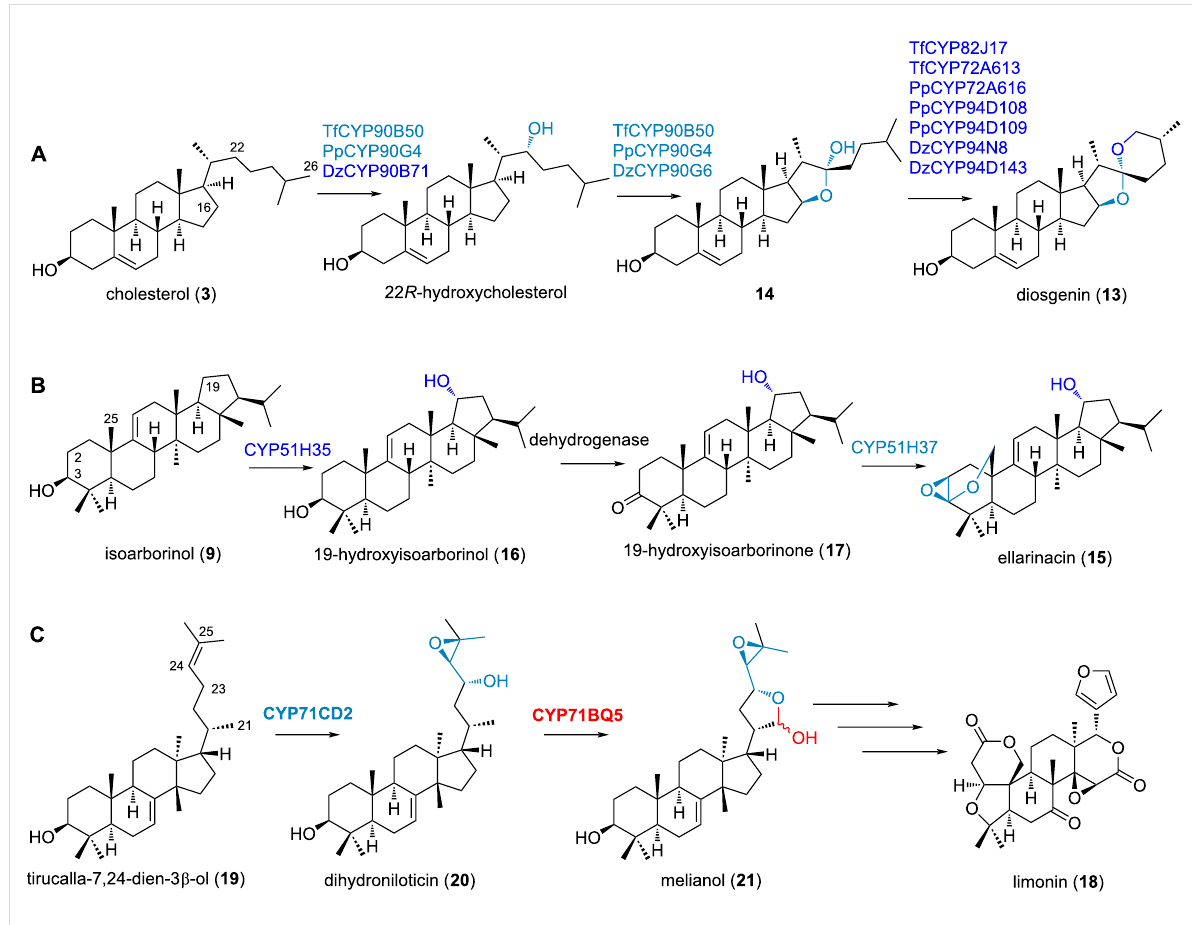
Figure 6: Recent examples of multifunctional CYPs in triterpenoid and steroid metabolism in plants that install complex oxidative modifications; in ad- dition, their discovery also showcases modern approaches to elucidate plant specialised metabolism. A) CYPs from different plants producing dios- genin ( 13 ) (Tf: Trigonella foenum-graecum ; Pp: Paris polyphylla ; Dz: Dioscorea zingiberensis ) [35,66]. B) Formation of the defence compound ellari- nacin ( 15 ) in bread wheat [26]. Stereochemistry of ellarinacin ( 15 ) is shown as published. C) Biosynthesis of the key intermediate melianol ( 21 ) in the pathway to the limonoid limonin ( 18 ) [29]. The stereochemistry is shown as published.